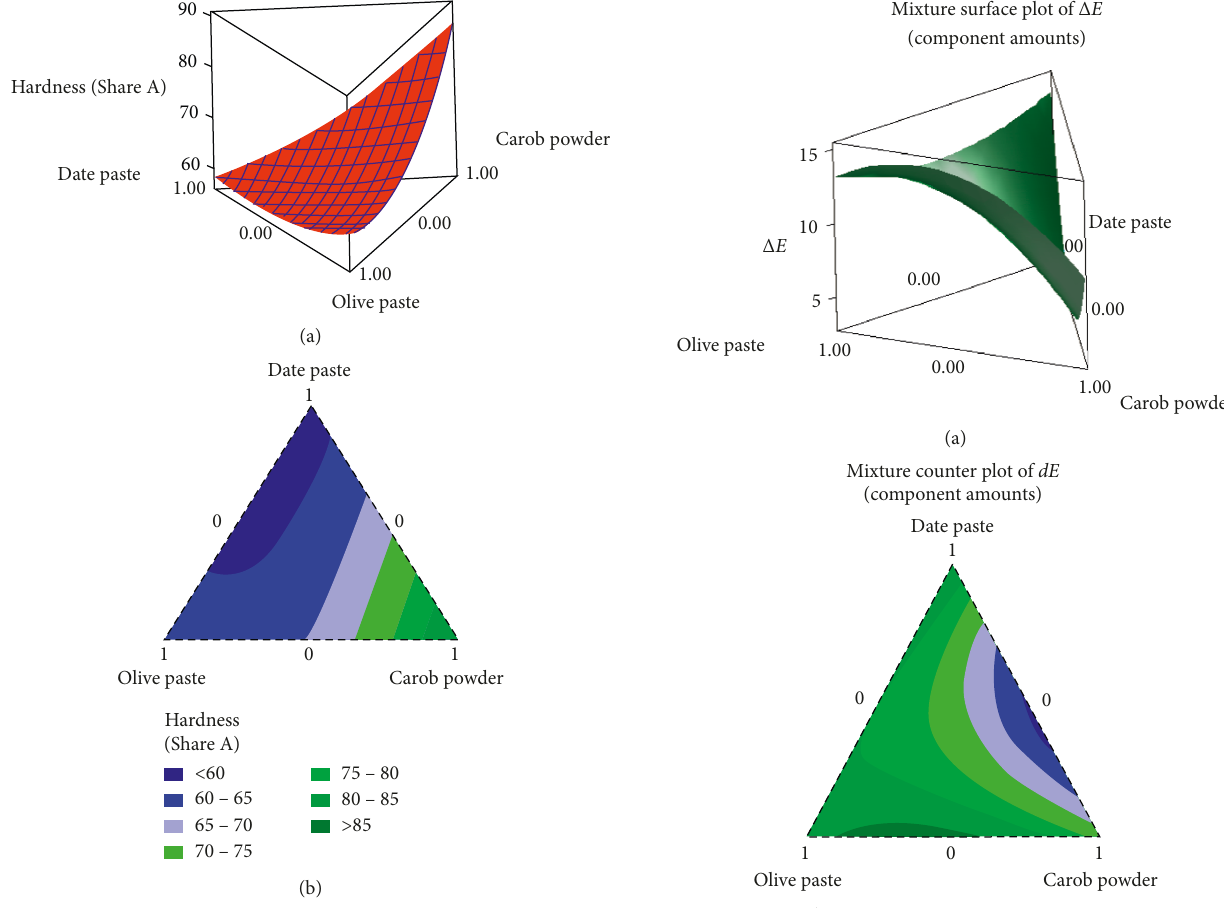
Figure 3: Response surface (a) and contour curve (b) related to the variation of candy hardness on function of proportions of basic components.